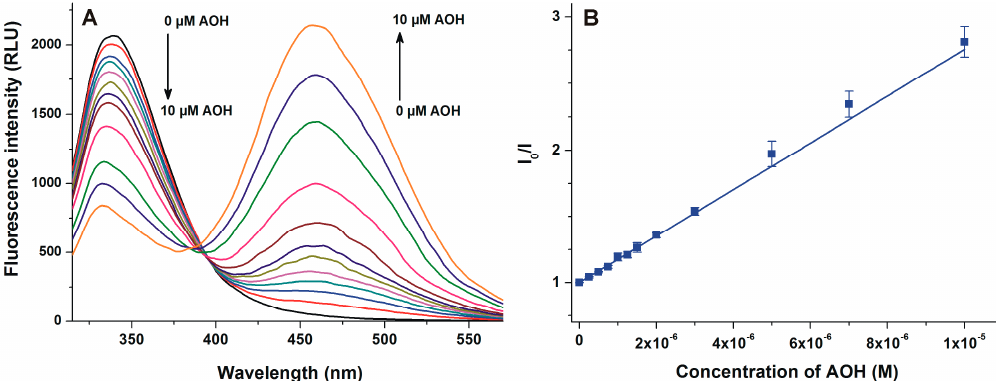
Figure 4. ( A ) Fluorescence quenching of HSA by AOH. Fluorescence emission spectrum of HSA (2 μ M) in the presence of increasing concentrations of AOH (0.0, 0.25, 0.5, 0.75, 1.0, 1.25, 1.5, 2.0, 3.0, 5.0, 7.0, and 10.0 μ M) in PBS (pH 7.4; λ ex = 295 nm); ( B ) Stern-Volmer plot of AOH-HSA interaction ( λ ex = 295 nm, λ em = 340 nm).